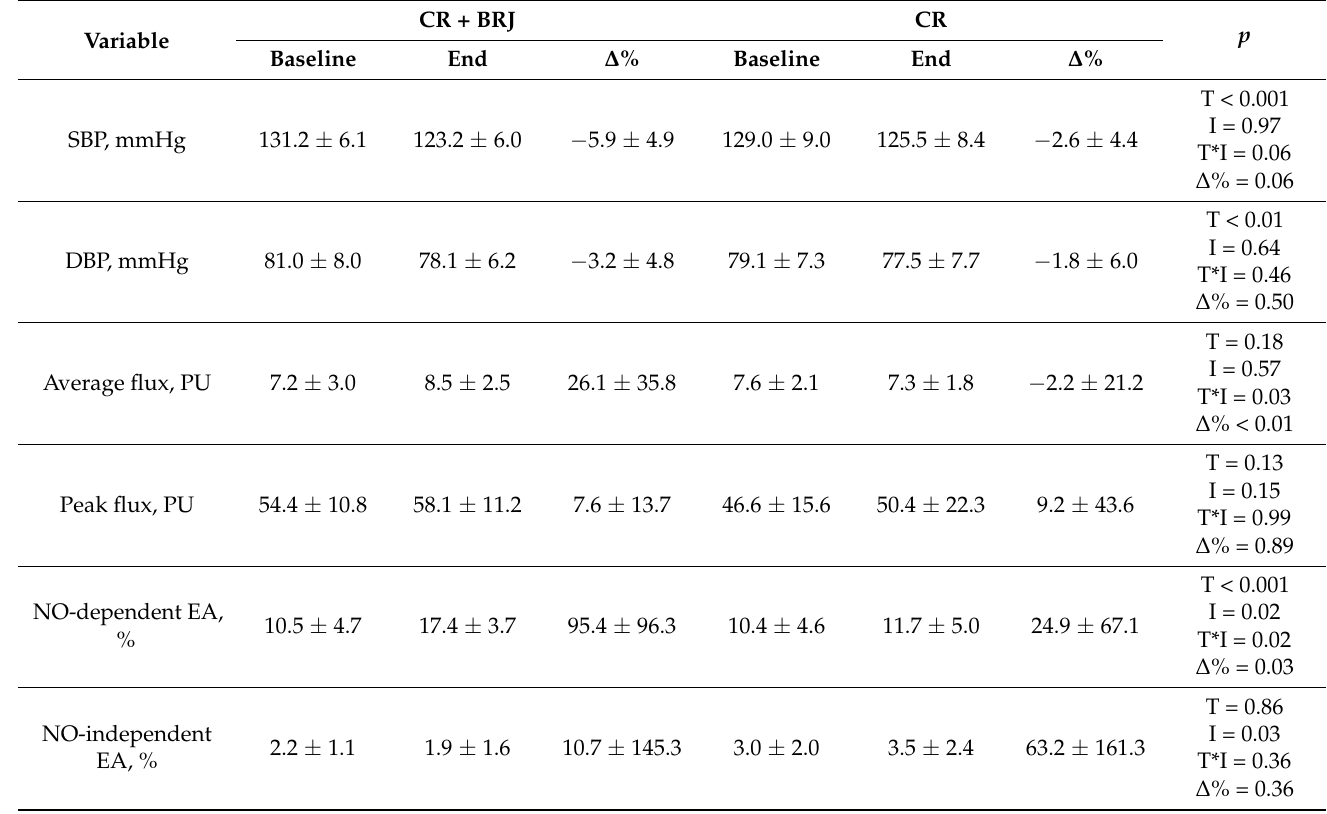
Table 3. Vascular